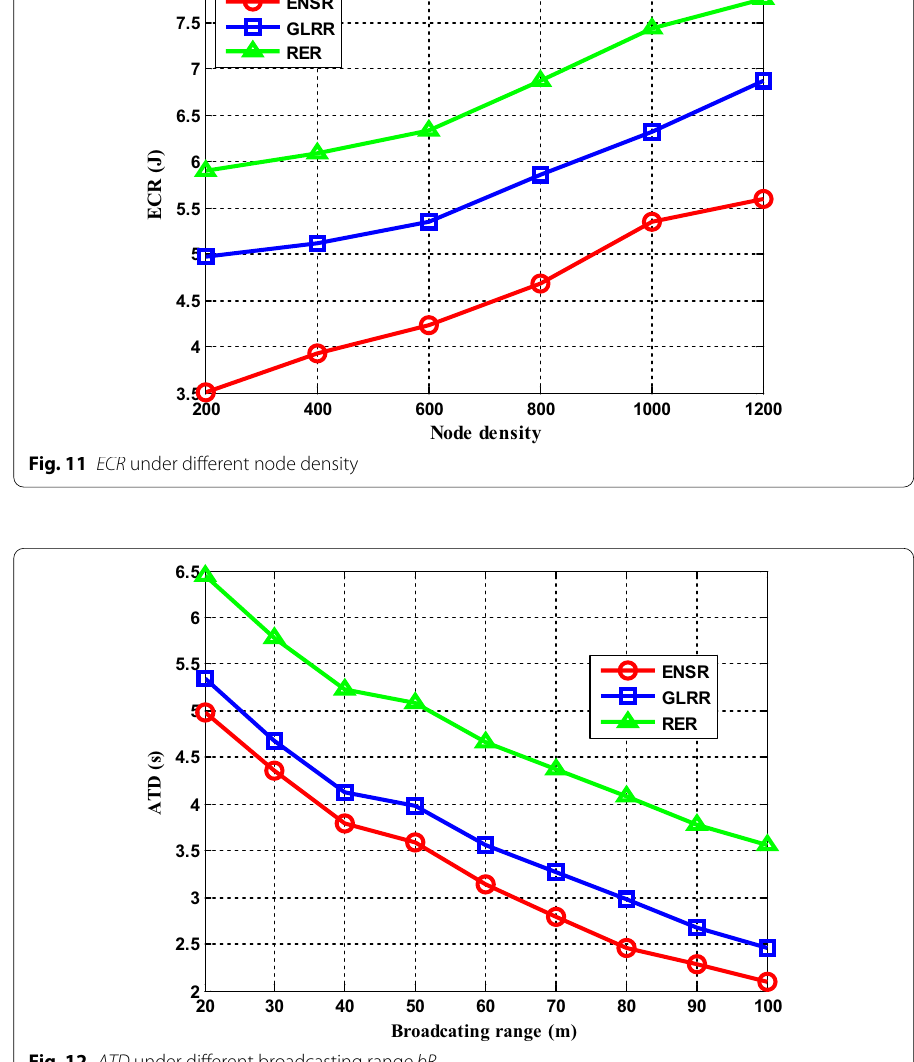
Fig. 12 ATD under different broadcasting range